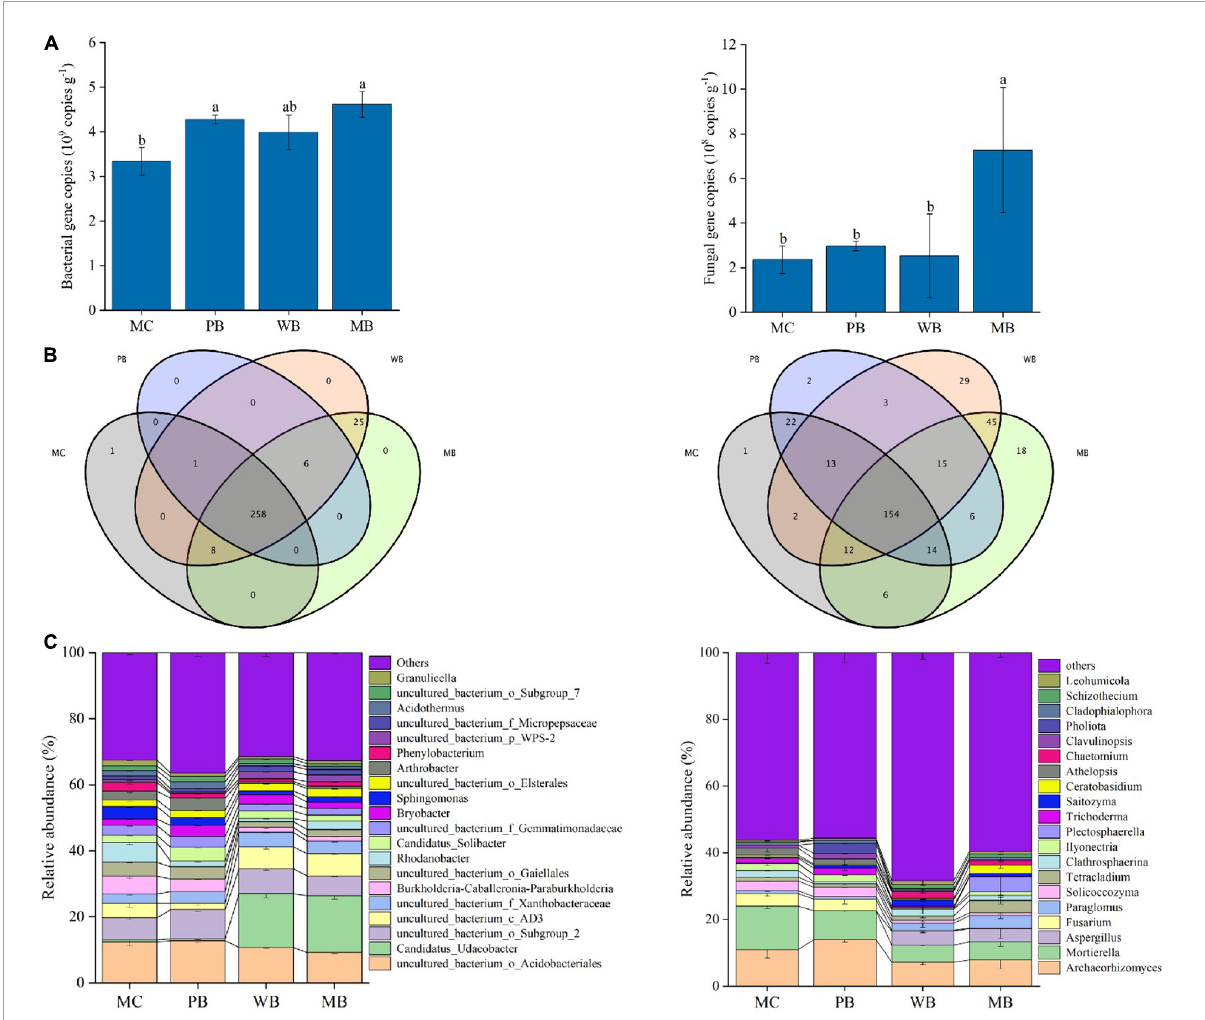
FIGURE4 Gene abundance (A) , exclusive and shared of OTUs at the genus level (B) , and top 20 genera composition (C) of bacterial (left) and fungal (right) of the rhizosphere soil sampled on the 3-year following soil amendment at 20 t ha − 1 . MC, amendment of manure compost at 20 t ha − 1 ; PB, WB, and MB, amendment of pig manure, wood, and maize biochar at 20 t ha − 1 . Different letters above the bars indicated a significant difference among treatments at p <